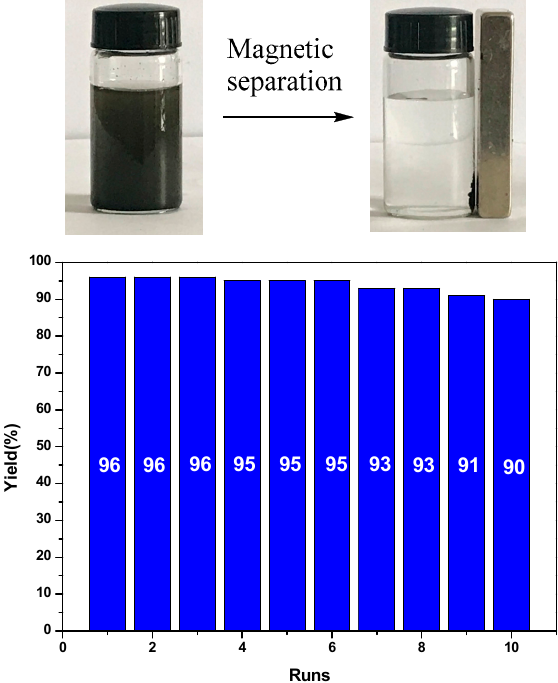
Figure 5. Recycling and reuse of Fe 3 O 4 @NC/Pd in the Suzuki coupling.